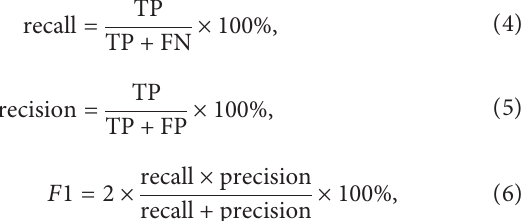
Figure 12: Illustration for parameter settings in this study. (a) Selection of voxel size d 2D horizontal distance d 2 D